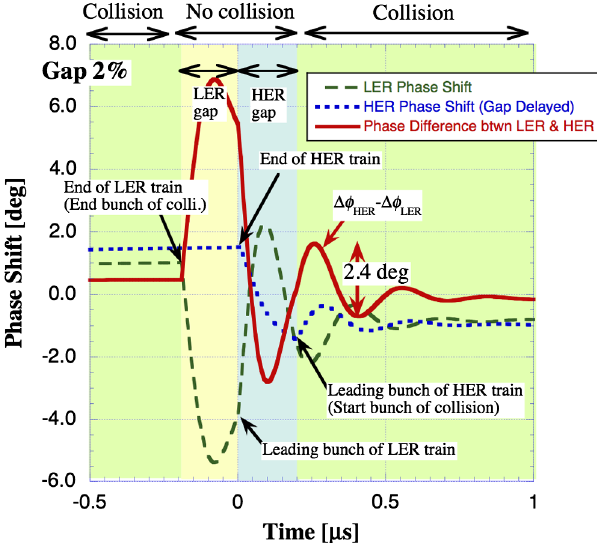
FIG. 13. Phase difference between LER and HER (red solid line) for a HER gap delay of 200 ns. The phase difference at the leading part of the train is reduced to 2.4 degrees for the collision.